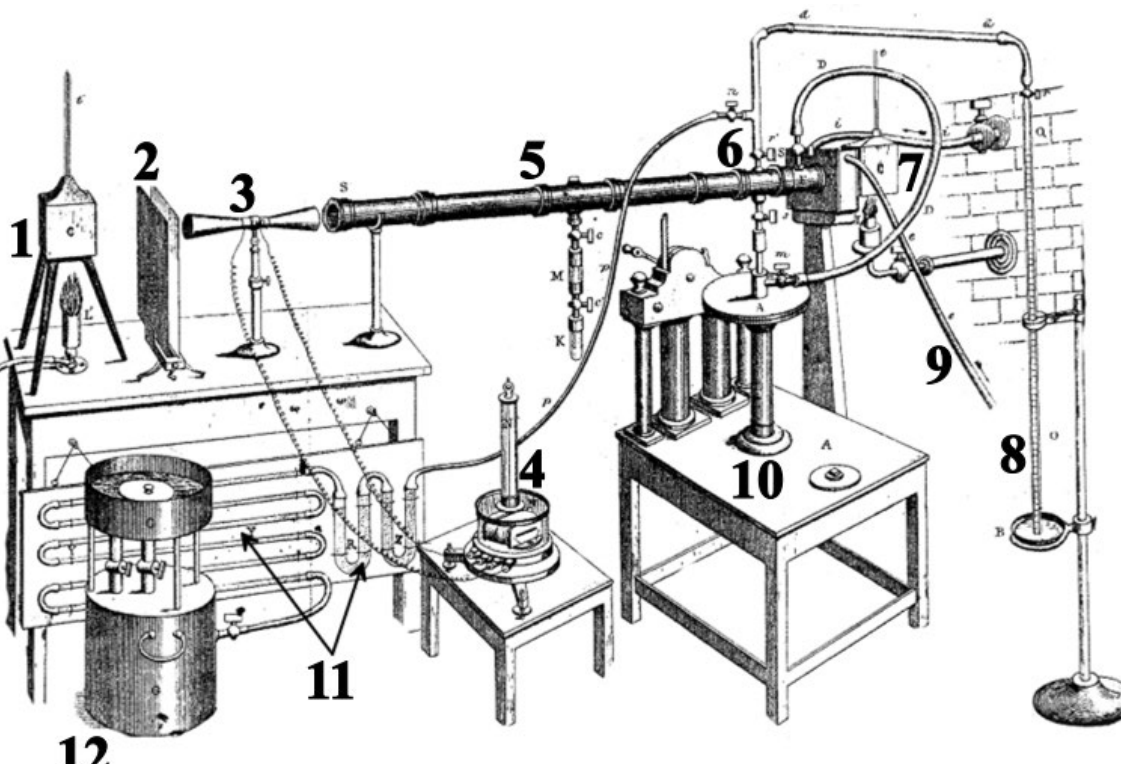
Figure 3. 1: Heat source. 2: Heat screen. 3: Thermopile, with conical reflectors. 4: Galvanometer. 5: Brass tube with rock salt plugs at each end. The tube contains the gas that is under study. 6: Gas enters tube. 7: Heat source. 8: Manometer. 9: Circulating cold water solves a heat conduction issue. 10: Vacuum pump. 11: The gas or gas mixture can pass through some filtration process beforehand. 12: Container of gas or gas mixture to be